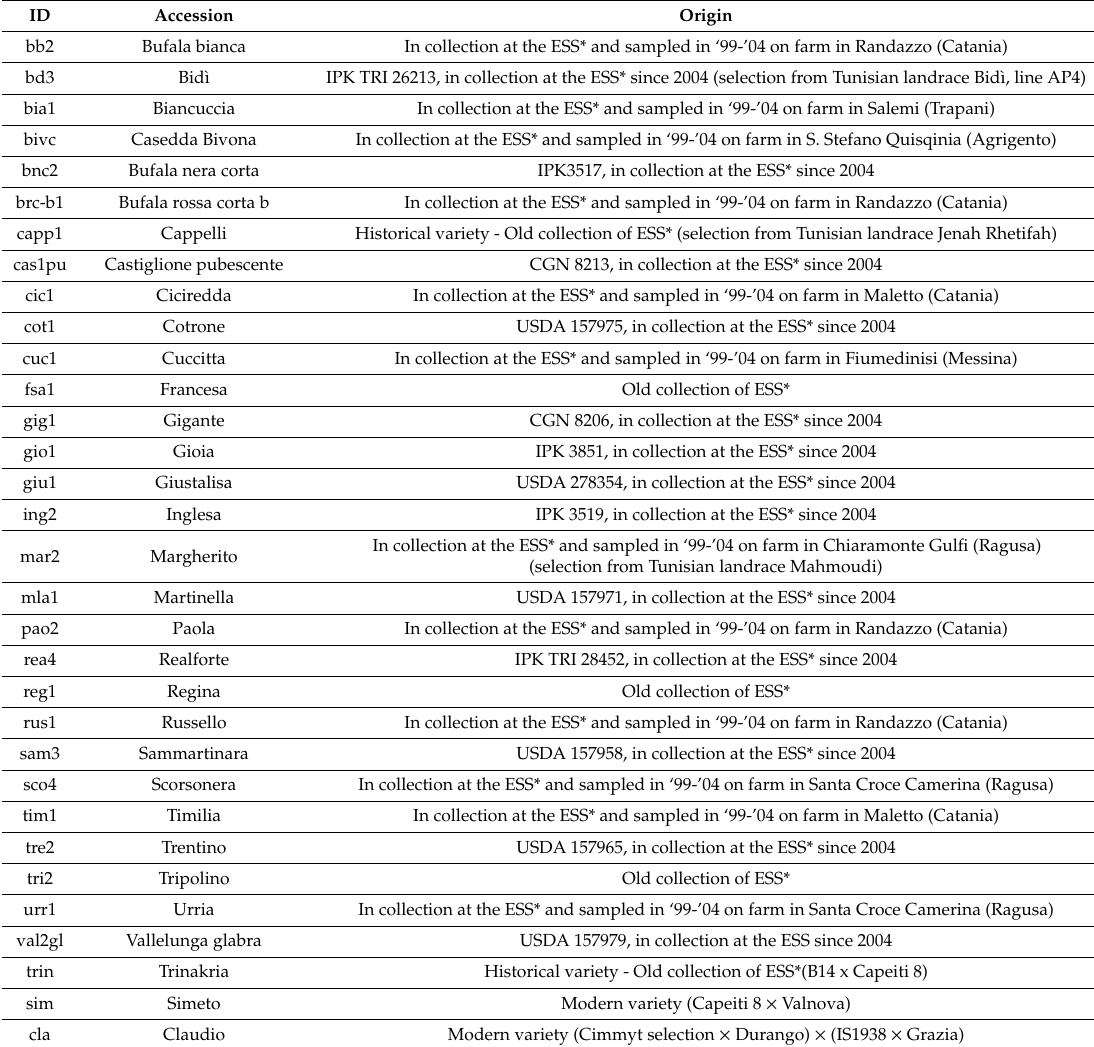
Table 3. List of wheat samples characterized by 90K SNP array, agro-morphological, phenological, and quality-related